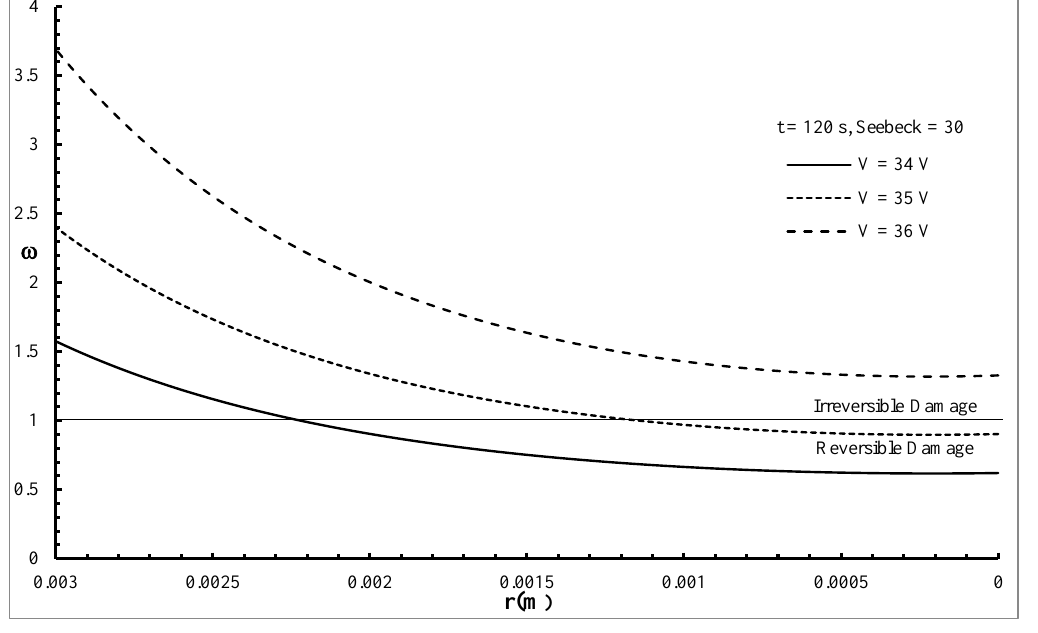
Figure 12 . The thermal damage distribution of liposarcoma tumor with various values of voltage when 600 e R   .